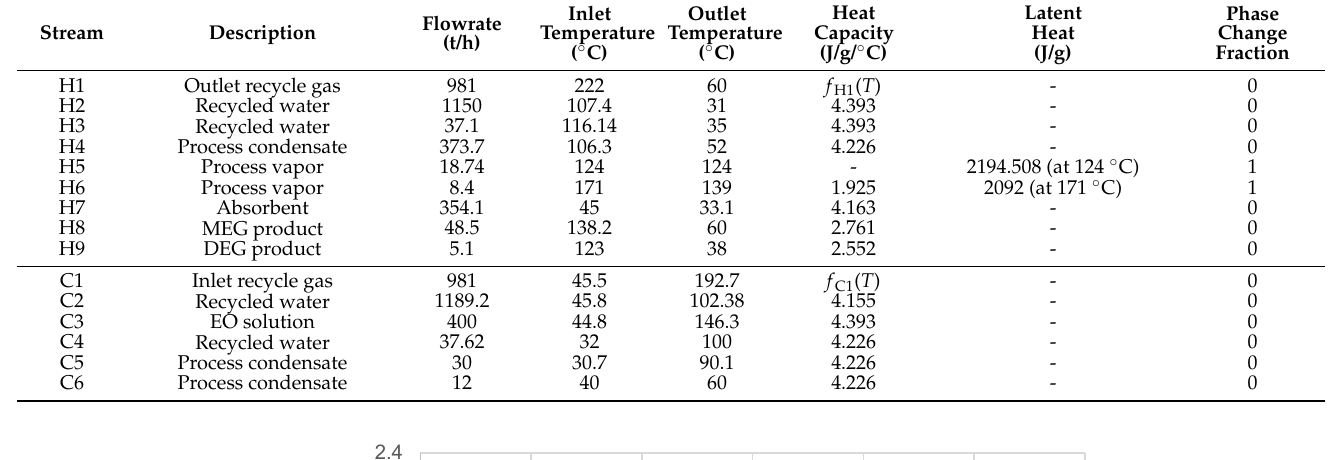
Table 6. Updated process stream data.